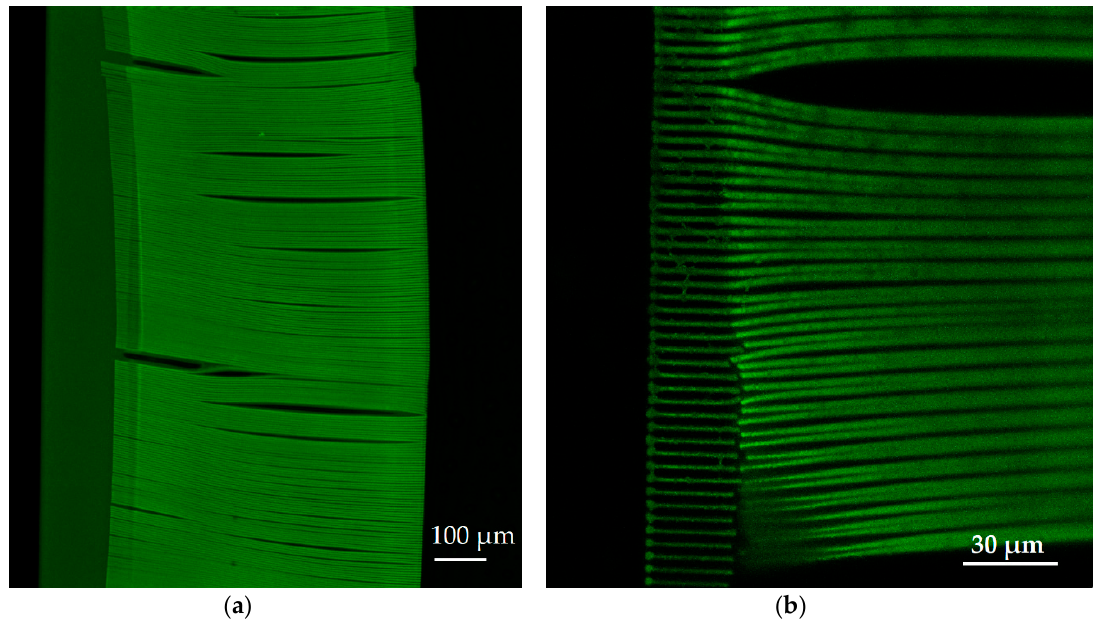
Figure 10. Deformation of the printed structures during development: ( a ) deformed and ( b ) cracked structure of the wire membrane.